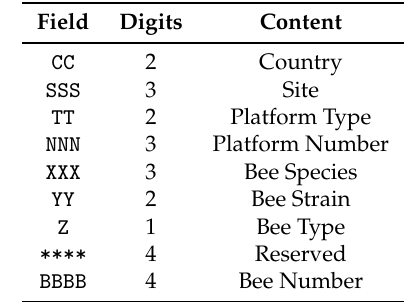
Table 3. The encoding for RFID tags. All digits are in hexadecimal, except ’Bee Number’ which is assigned to four decimal